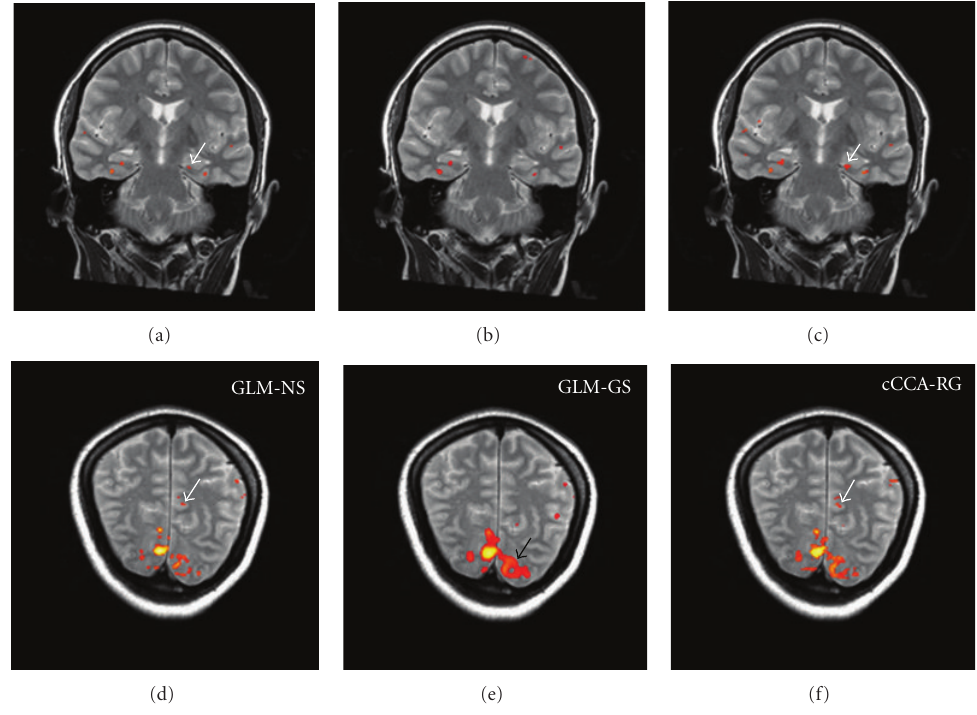
Figure 8: Activation maps for the contrast E-C of the memory paradigm using corrected P -values ( P < 0 . 05). Upper row: activations in the anterior portion of the hippocampal complex; lower row: activations in the posterior and middle cingulate cortex and in the precuneus. Note that GLM-NS and cCCA-RG lead to symmetric (left and right) activation patterns in the hippocampus and parahippocampal gyrus and also to weak and localized activations in the posterior/middle cingulate cortex (see white arrows). Using GLM-GS, strong activation patterns become overly bulgy (see black arrow). Compared to GLM-NS, cCCA-RG yields more activated voxels and better connected activations confined to gray